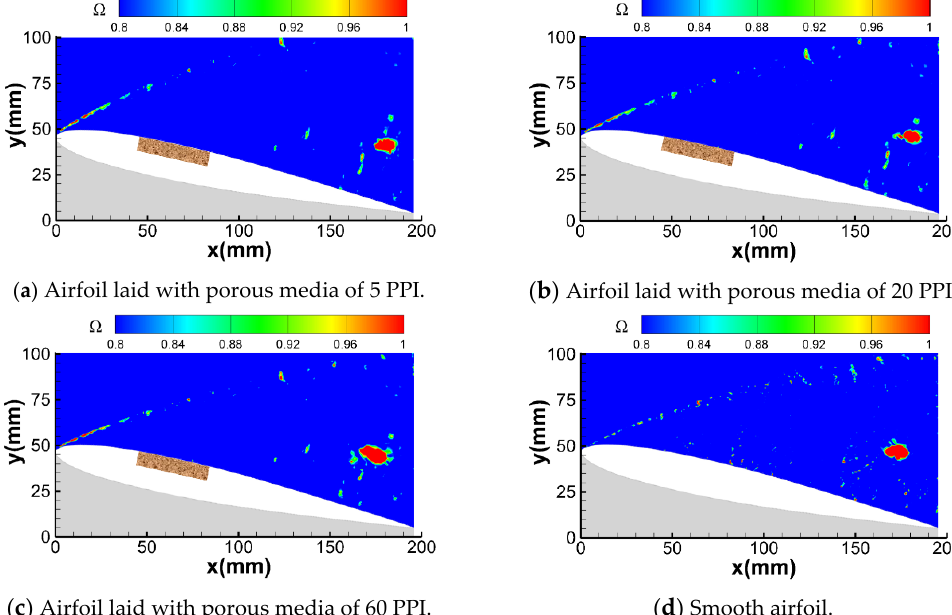
Figure 9. Time-averaged results of vortex core boundary with Ω criterion (AOA = 12).